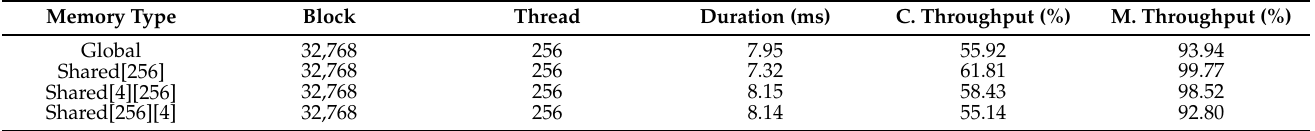
Table 3. Performance comparison by memory type (C.: compute; M.: memory).